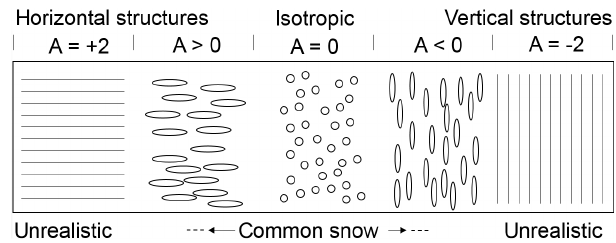
Figure 1. Different structures and their anisotropy according to Eq. (1). Snow shows only a small anisotropy and can never reach the extreme cases of horizontal planes or vertical